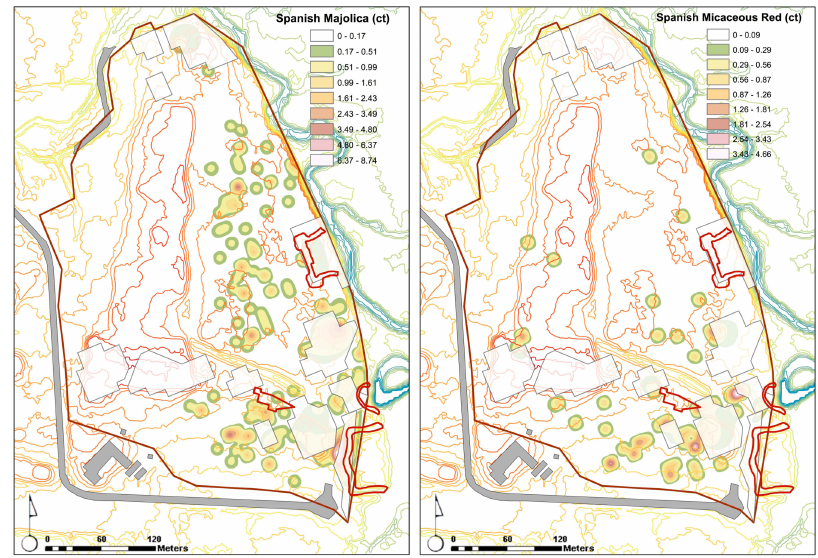
Figure 17. The distribution of Spanish period Majolica ( left ) and micaceous red ware ( right ) ceramics recorded through a shovel test survey. Areas whited-out were not shovel tested. Contour spacing is 1 m. Contours are based on the LiDAR dataset and use the NAD 1983 and NAV 1988 horizontal and vertical datum, respectively.